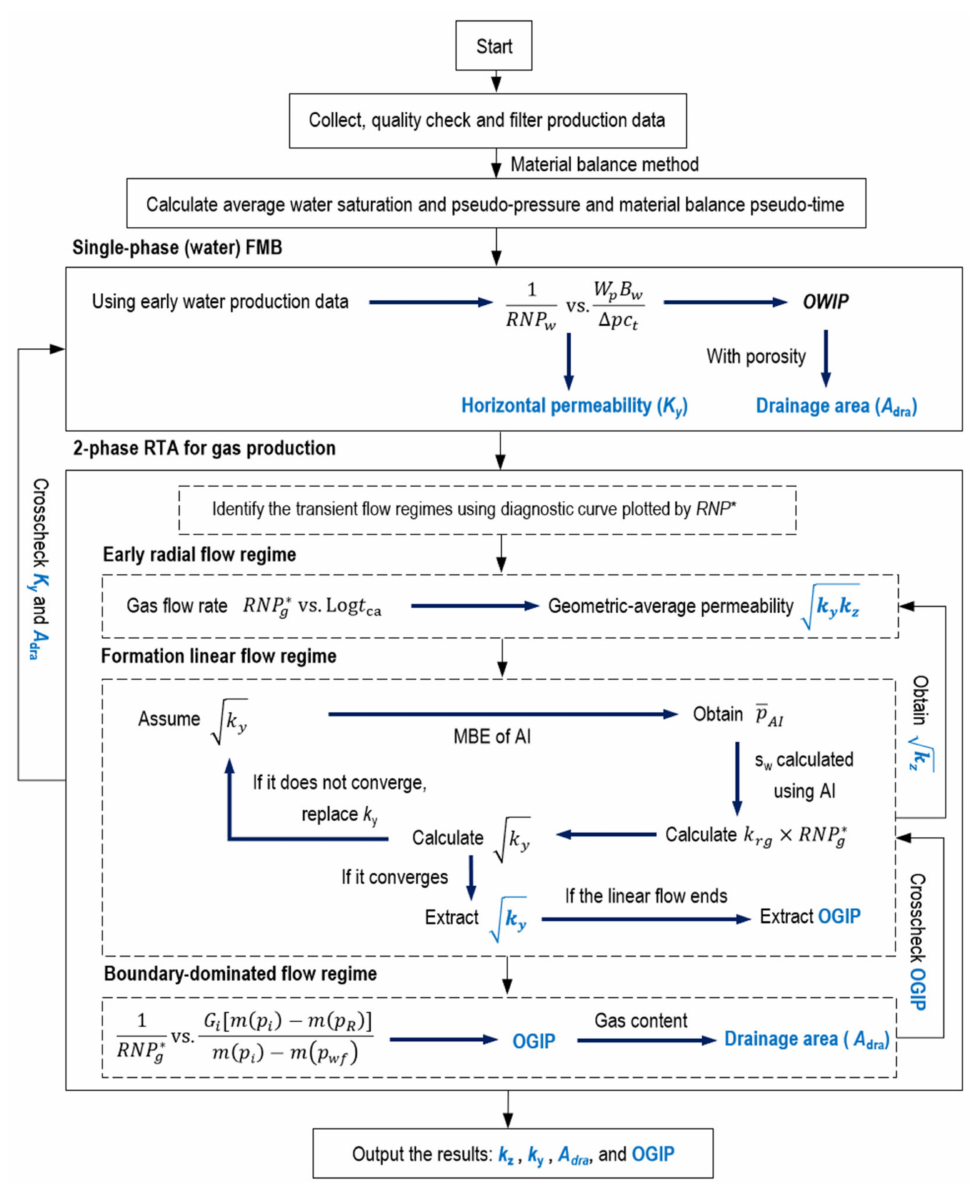
Figure 3. Generalized workflow for two phase RTA of a horizontal well in an under-saturated CSG